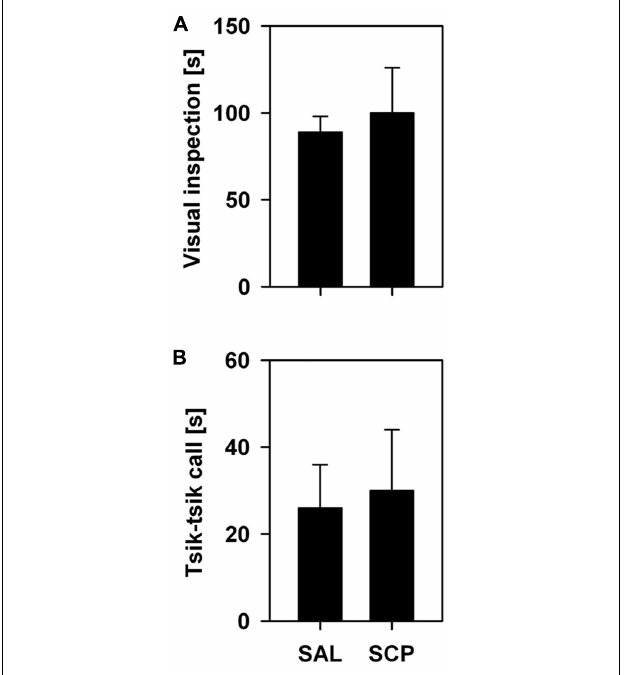
FIGURE 3 | Mean time (+SEM; in seconds) spent visually inspecting the snake model (A) and emitting tsik–tsik alarm vocalizations (B) by the saline (SAL; n = 4) and SCP (0.03 mg/kg SCP; n = 5) treated marmosets during the 10 min snake-exposure trial of the Fear-Motivated Behavior (FMB)